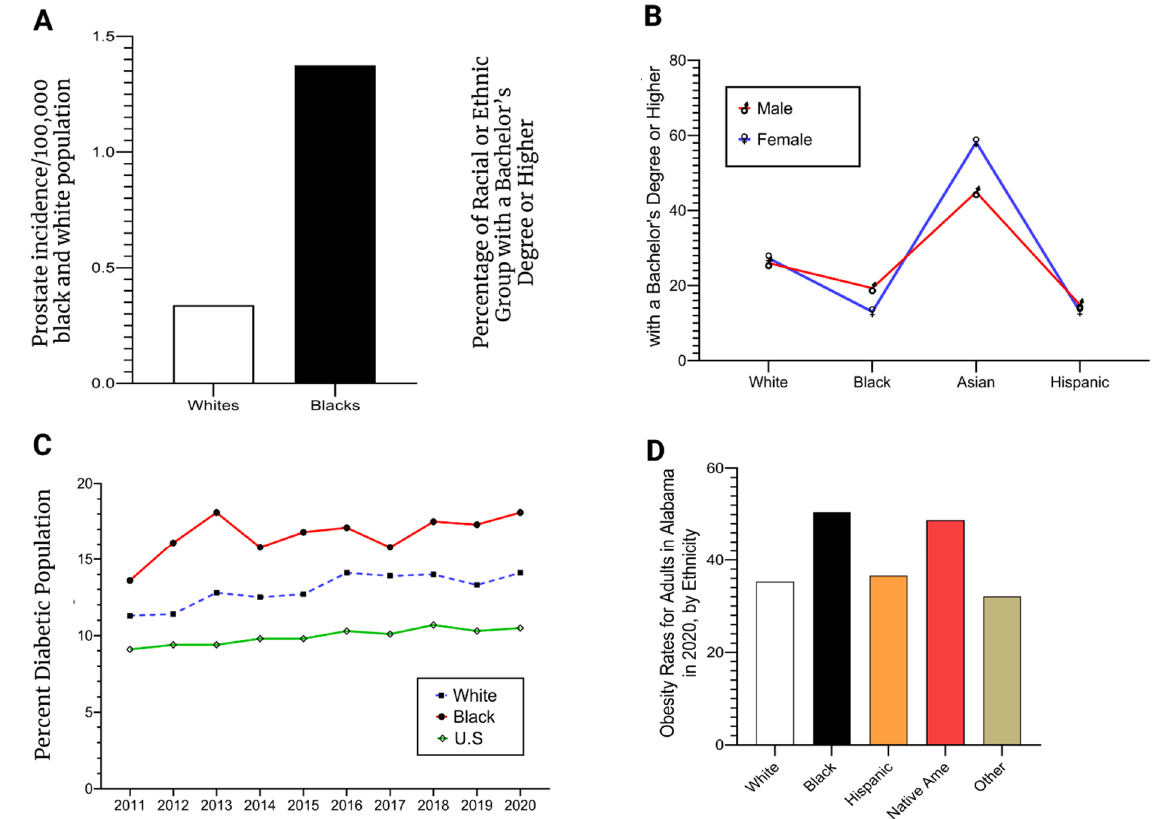
Figure 5. Four factors that cause prostate cancer health disparity in Alabama. ( A ) represents the prostate cancer rate (%) for Alabama’s white and African American male population. The county-level prostate and population (for white and African American males) data were separately aggregated and divided by 100% to obtain the percentage. Although African American is only 27 percent of the state population, African American males face a considerable spike in prostate cancer compared to the white male population. Similarly, ( B ) displays the 4-year college-level degree achievement, ( C ) illustrates the diabetes epidemic, and ( D ) depicts the obesity status in Alabama. Data source: 5A-Prostate Cancer Incidence, Black and White Male Population; American Cancer Society (2019), accessed on 25 December 2021; 5B-Percentage of Racial or Ethnic Group with a Bachelor Degree or Higher; U.S. Department of Census (2018), accessed on 25 December 2021; Percentage Diabetes Population; Center for Disease Control, Behavioral Risk Factor Surveillance System, (2020), accessed on 25 December 2021; and Percentage Obesity Rates for Adult in Alabama; www.statista.Com, (2020) [2,24,25,54,61], accessed on 25 December 2021.